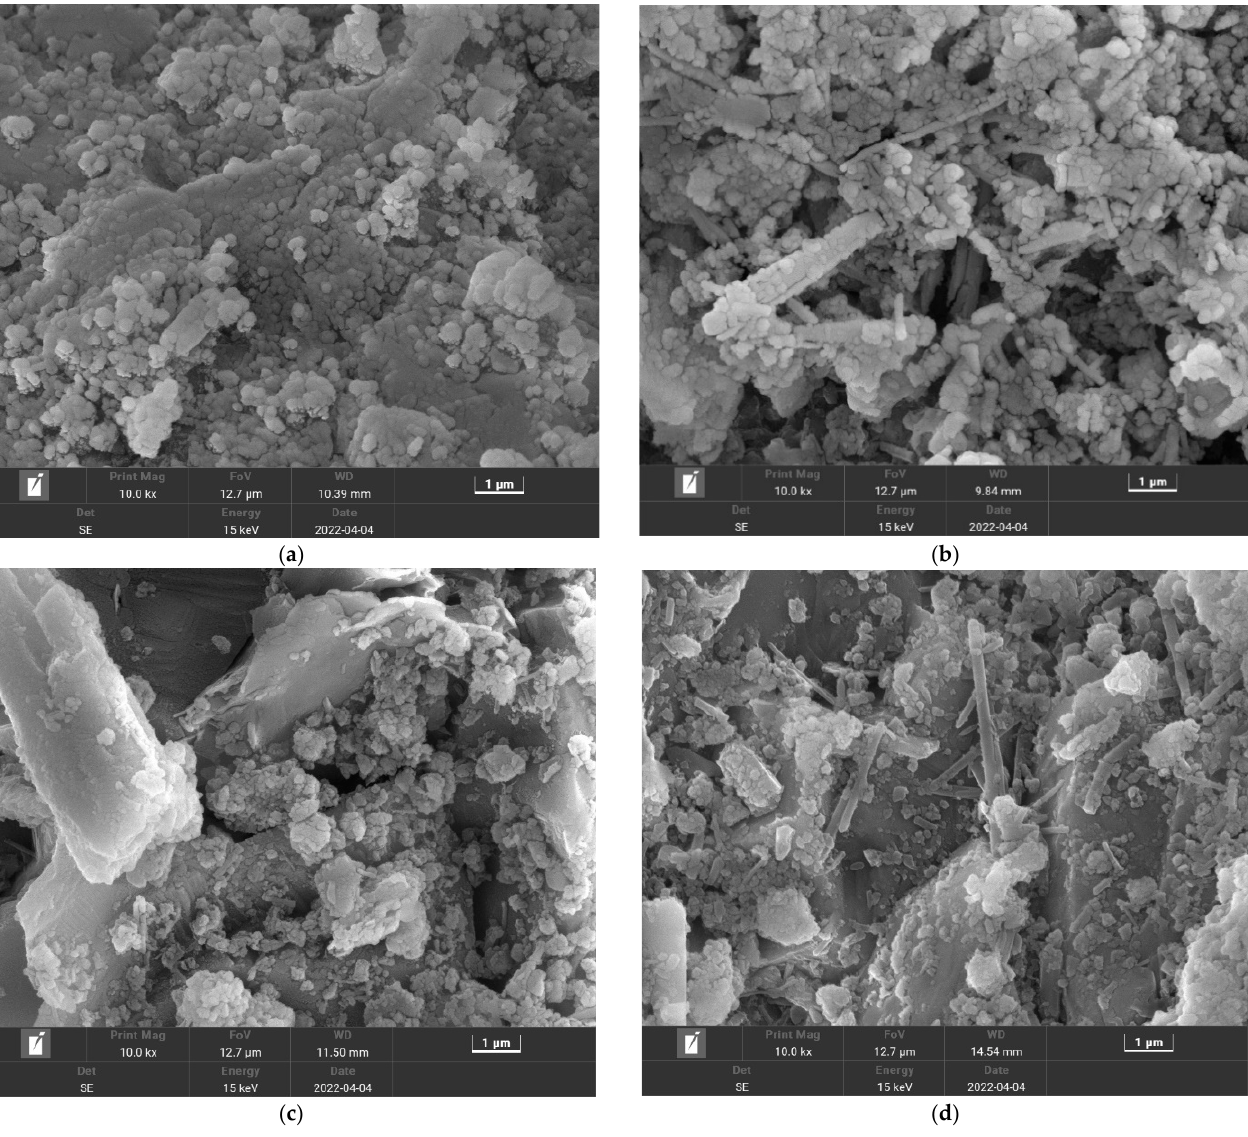
Figure 13. Microstructure of cement mortar with NR: (a) 1% NR; (b) 2% NR; (c) 4% NR; (d) 8% NR.